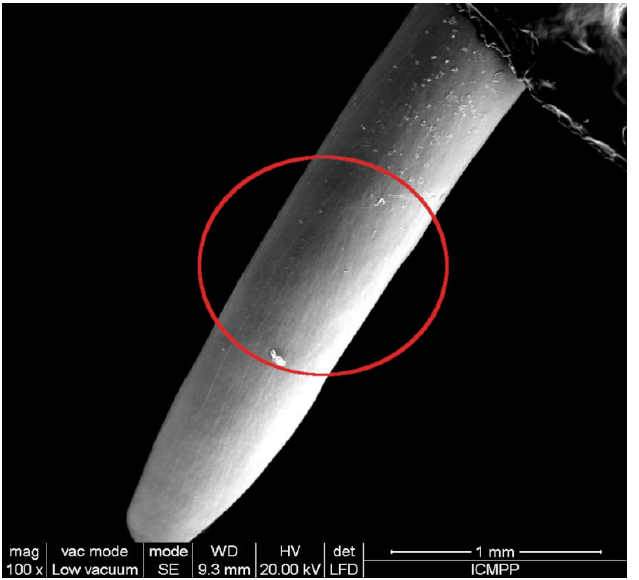
Figure 6. Lingual surface of CD1 mouse incisive (SEM). The red circle shows the area from which EDX and AFM data were collected.